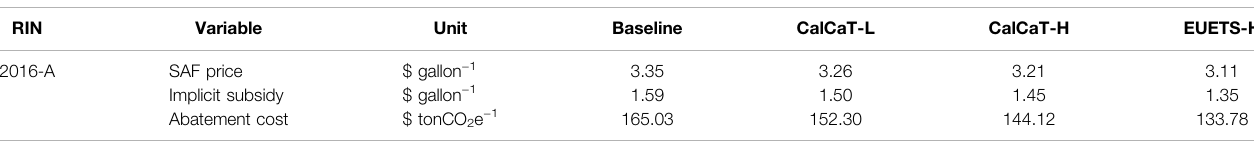
TABLE 7 | GHG emission abatement costs with conversion yield of 29.40 gallons ton − 1 .